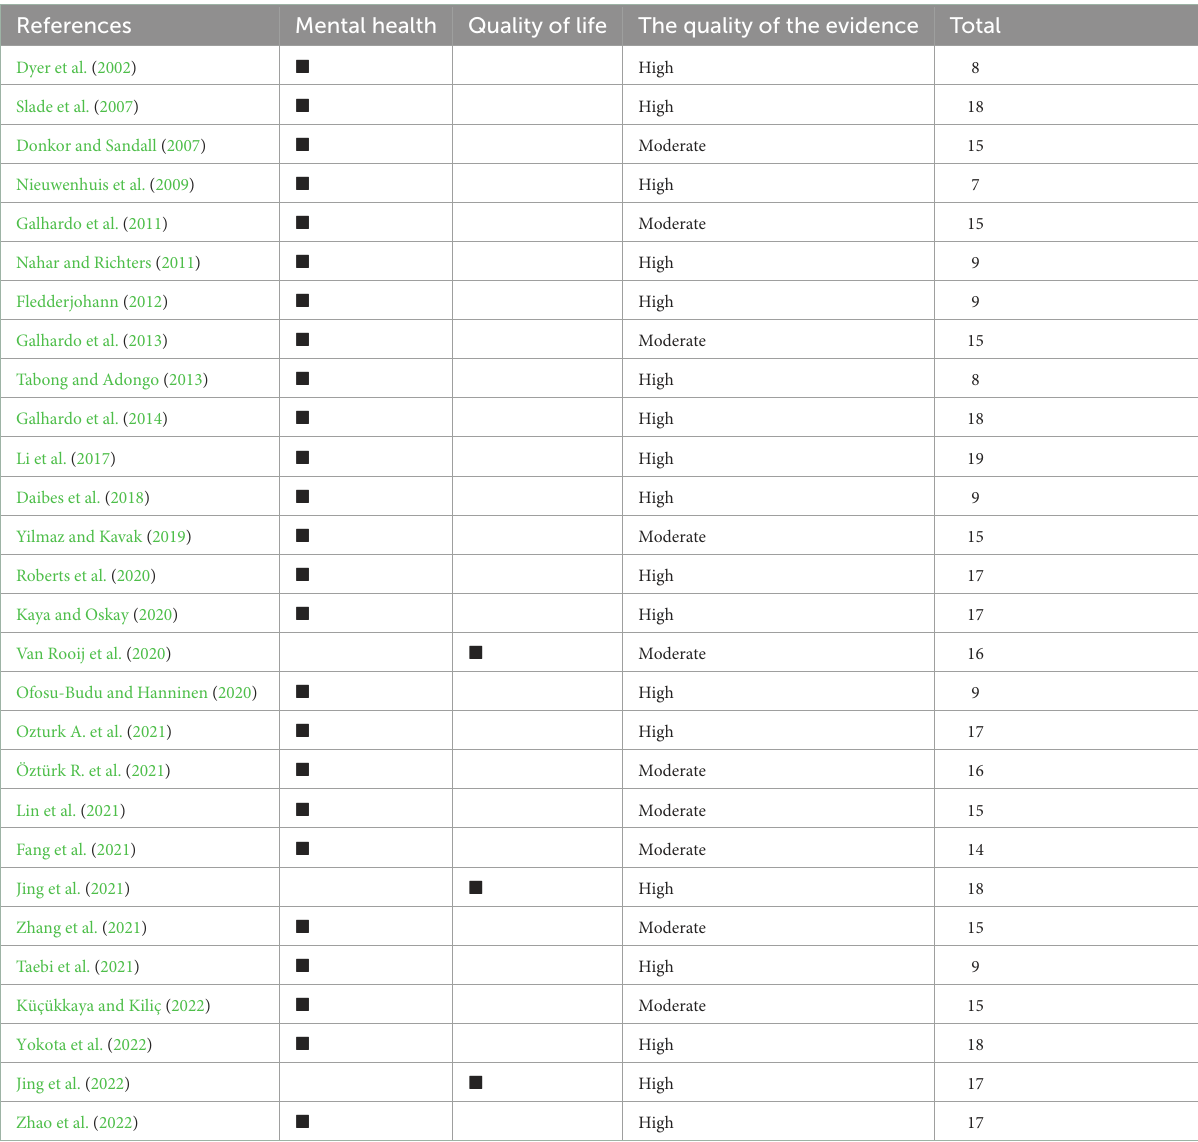
TABLE 1 Variables assessed and methodological quality of the studies included in the